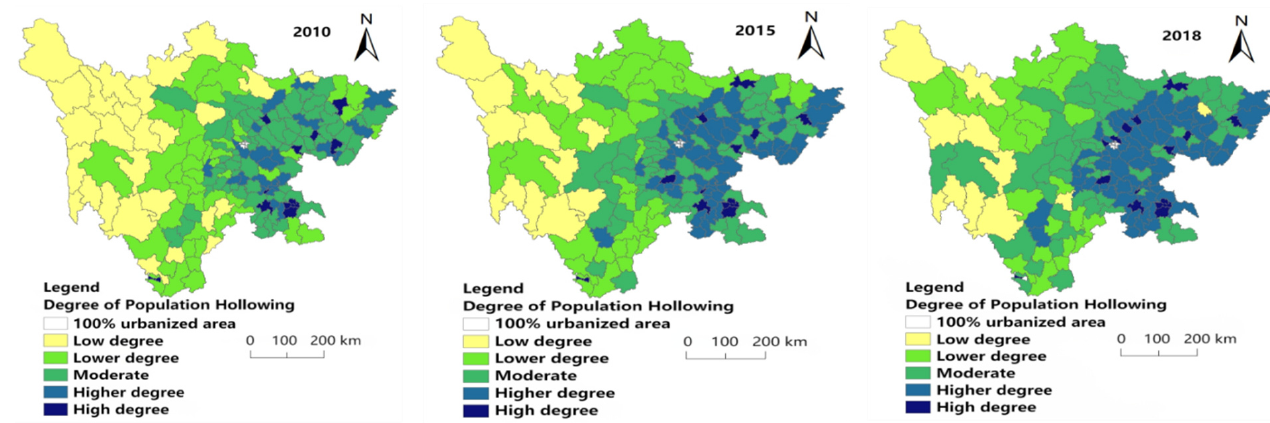
Figure 5. Spatial distribution of population hollowing degree in 2010, 2015 and 2018.